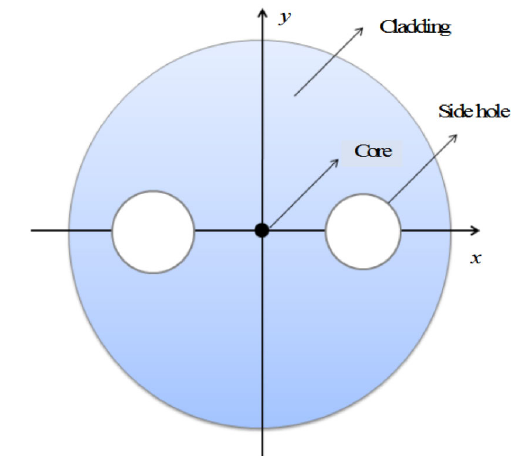
Fig. 1 Cross-section schematic of circular-core side-hole